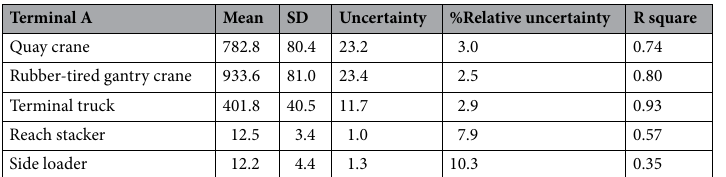
Table 4. Uncertainty results for terminal A.